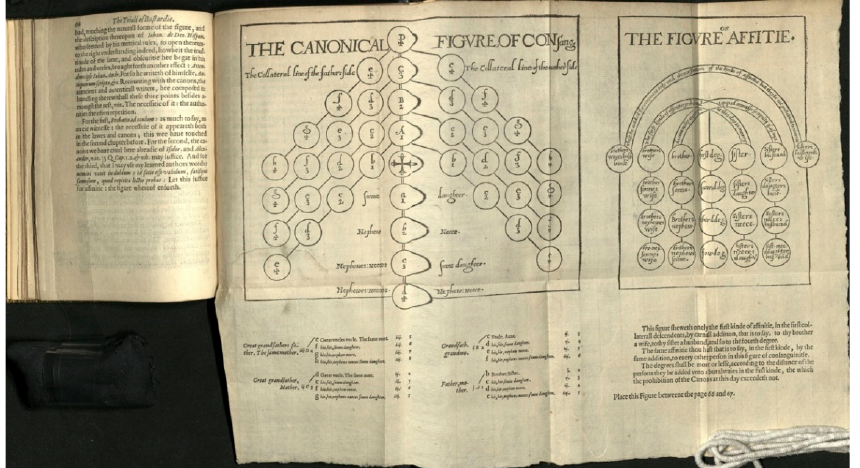
Figure 2. The Canonical Figure of Consang[uinity]/The Figure of Affi[ni]tie, tables inserted between